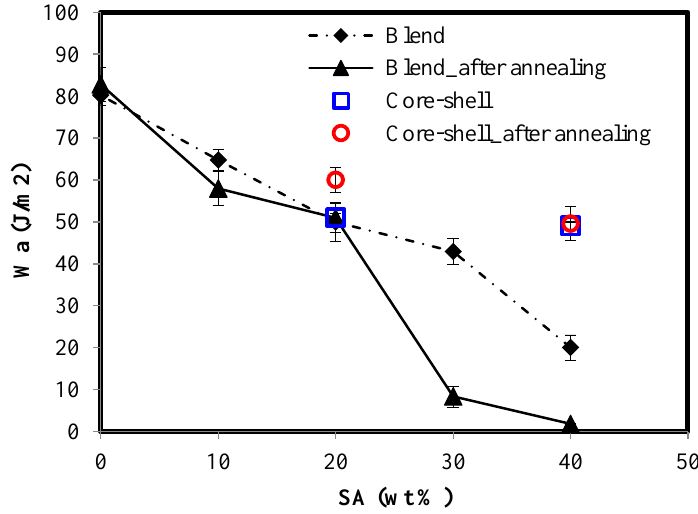
Figure 1. Effect of annealing on the work of adhesion of the adhesive tapes cast from blends and core-shell latexes.